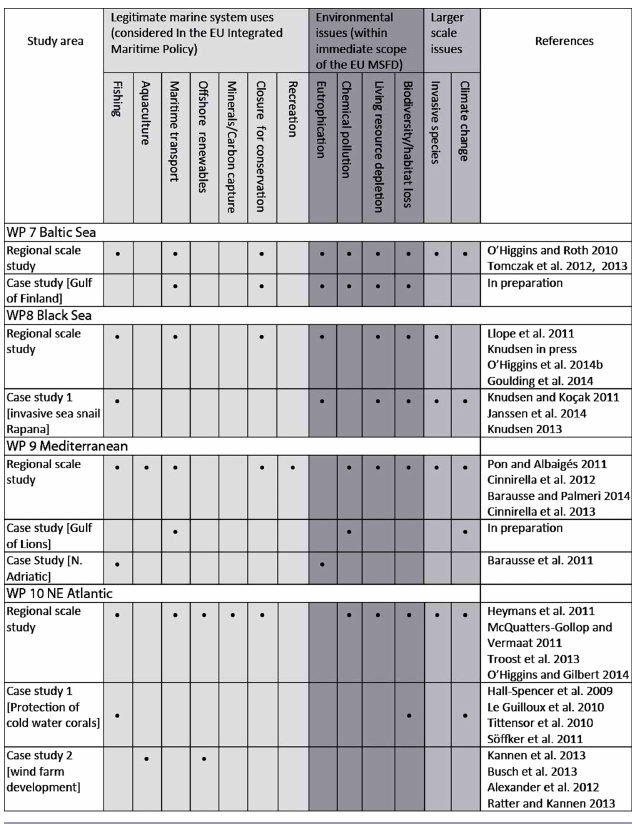
Fig. 3 . KnowSeas regional studies and subregional case studies, showing issue selection criteria (EU MSFD = European Union Marine Strategy Framework